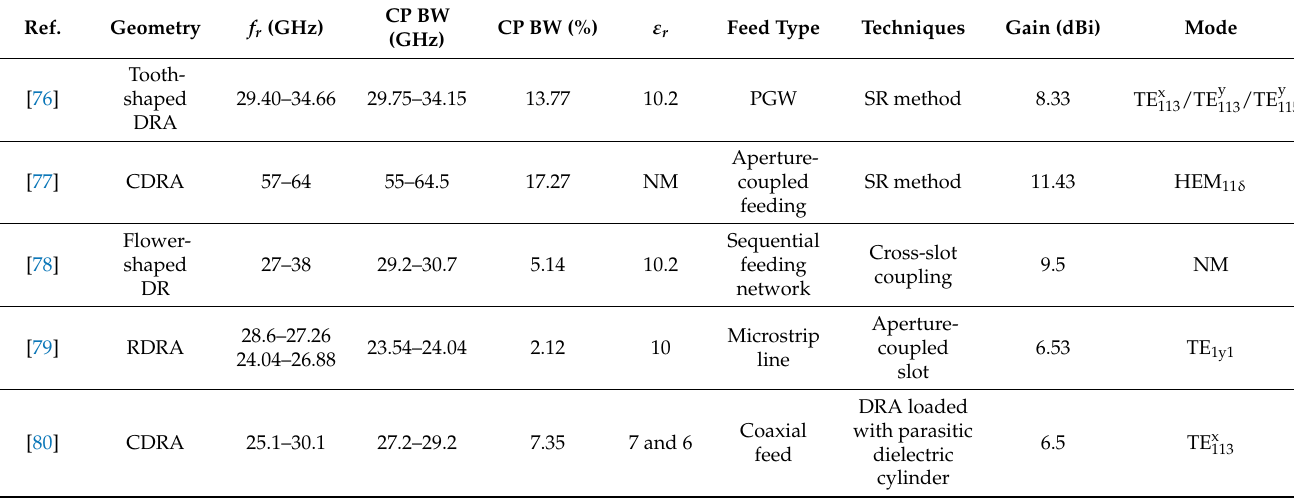
Figure 19. Proposed DRA: ( a ) perspective view; ( b ) bottom feed network [78]. Table 6. Comparison between various mm-wave circularly polarized DRAs.